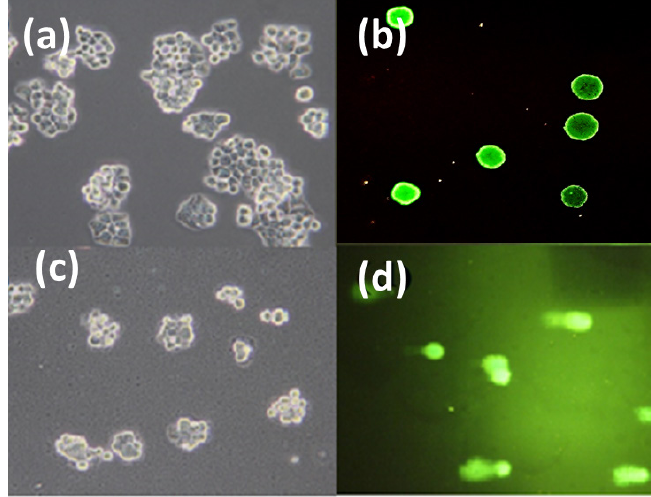
Figure 10. Microphotographs of bright field and fluorescent microscopic views of HT-29 cells: ( a ) Bright field view of untreated control cells (undamaged cells); ( b ) fluorescent microscopic view of untreated control cells (undamaged cells); ( c ) bright field view of cells treated with IAA (1 mM) and IBN-4-HRP (100 μg/mL) ( shrunken morphologies); and ( d ) fluorescent microscopic view of cells IAA (1 mM) and IBN-4-HRP (100 μg/mL) (damaged cells with elongated